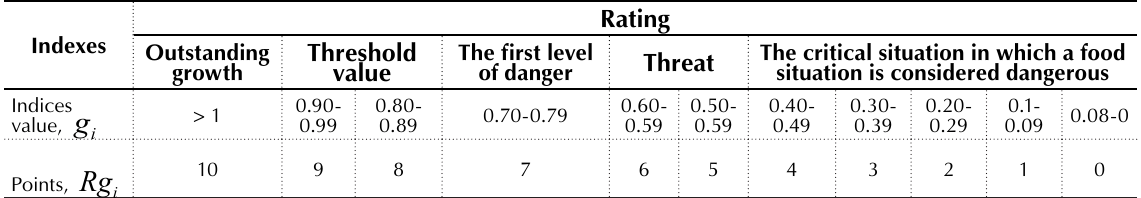
Table 2. Evaluation of standardized indicators